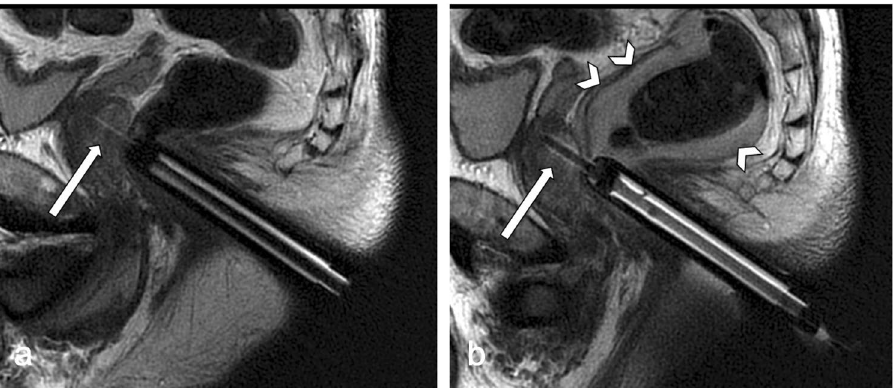
Figure 4. Rectal blood collection (arrowheads); sagittal T2 weighted fast imaging in a 67 years old patient with continued antiplatelet therapy; ( a ) first intraprostatic needle documentation (arrow); ( b ) needle documentation at the end of the intervention.